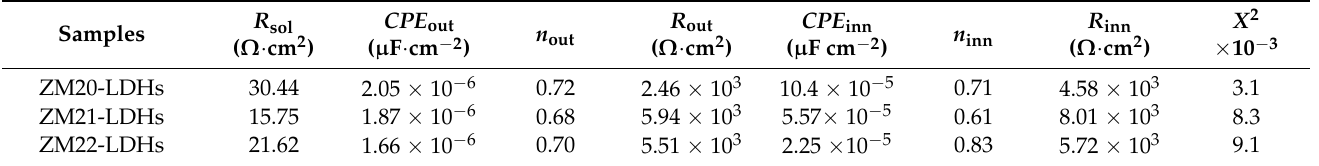
Figure 7. Bode plots of ( a ) |Z| and ( b ) phase angle vs. frequency for various specimens after 30 min immersion in 3.5 wt.% NaCl solution. Inset in Figure 7a is the equivalent circuit. Table 4. Corrosion potential ( E corr ) and corrosion current density ( i corr ) of the samples according to the Tafel polarization curve.